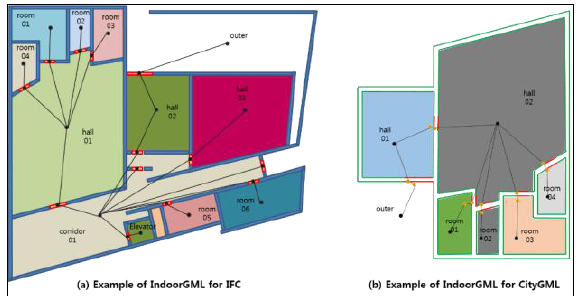
Figure 4. Node-Link graph in IFC and CityGML